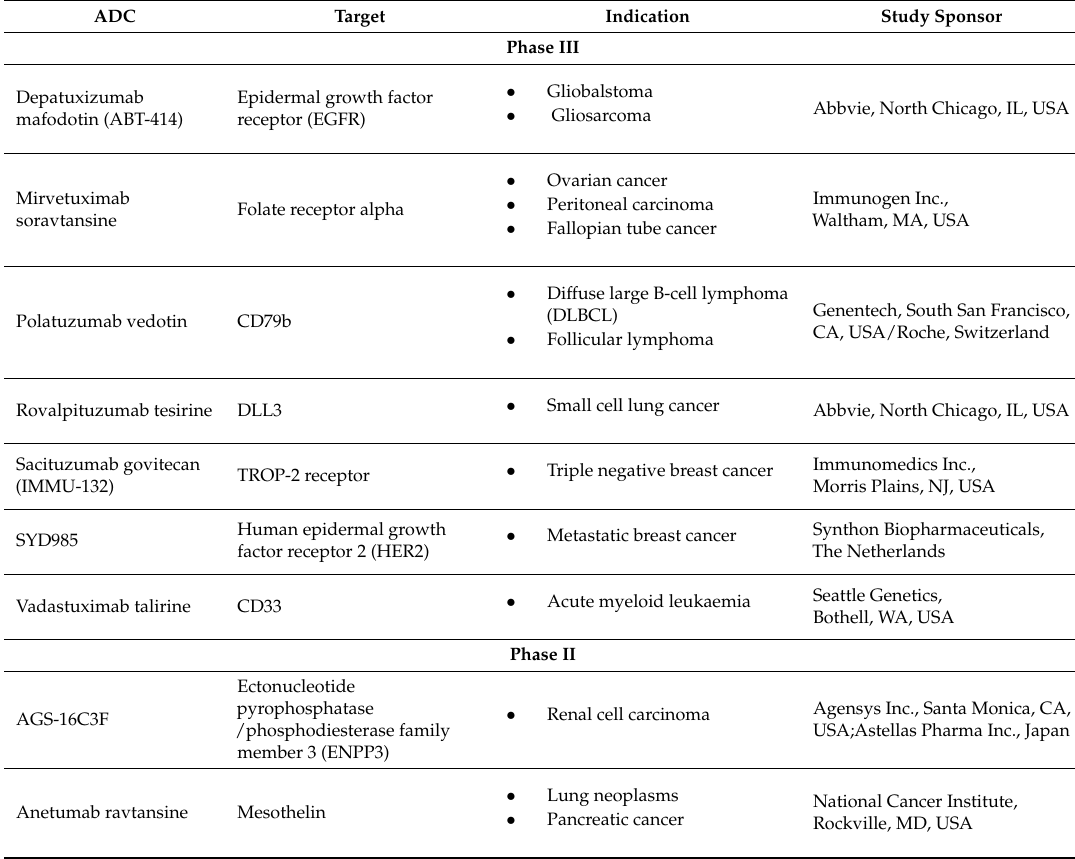
Table 1. Antibody-drug conjugates (ADCs) currently under evaluation in Phase II and Phase III clinical studies (source: